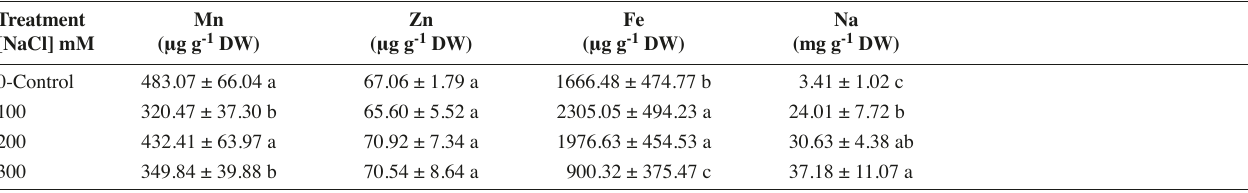
Tab. 5: Foliar concentrations of micronutrients and sodium in iceplant subjected to different salt conditions.